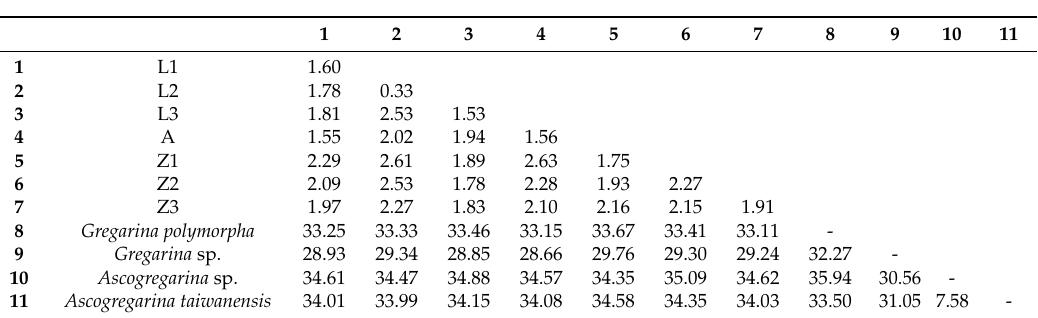
The average percentage of p -distances calculated applying a “population genetics approach”. Divergence values are assessed: within Gregarina specimens belonging to the same midgut micro-community (e.g., L1 vs. L1); among specimens isolated from different stages of Tenebrio molitor (e.g., A vs. L1); between different coleopteran species (e.g., L1 vs. Z1 in larvae of T. molitor and Zophobas atratus , respectively); and between our sequences (number 1 to 7) and those downloaded from GenBank